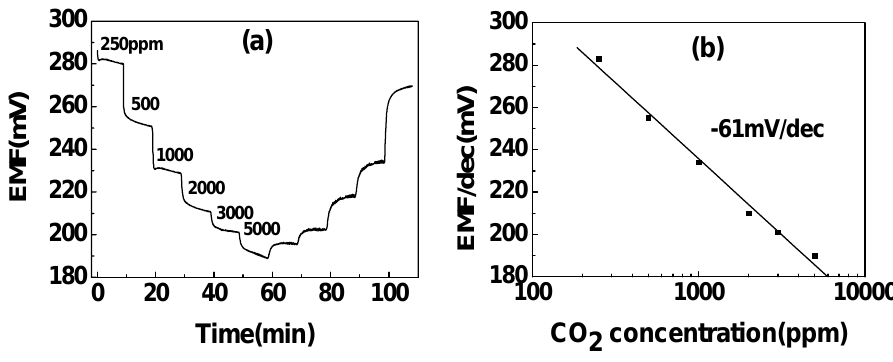
Figure 5. (a) Sensitivity and recovery and (b) ∆ EMF/dec measurements of the 1.2 µ m thickness electrolyte sensor at 500 o C operating